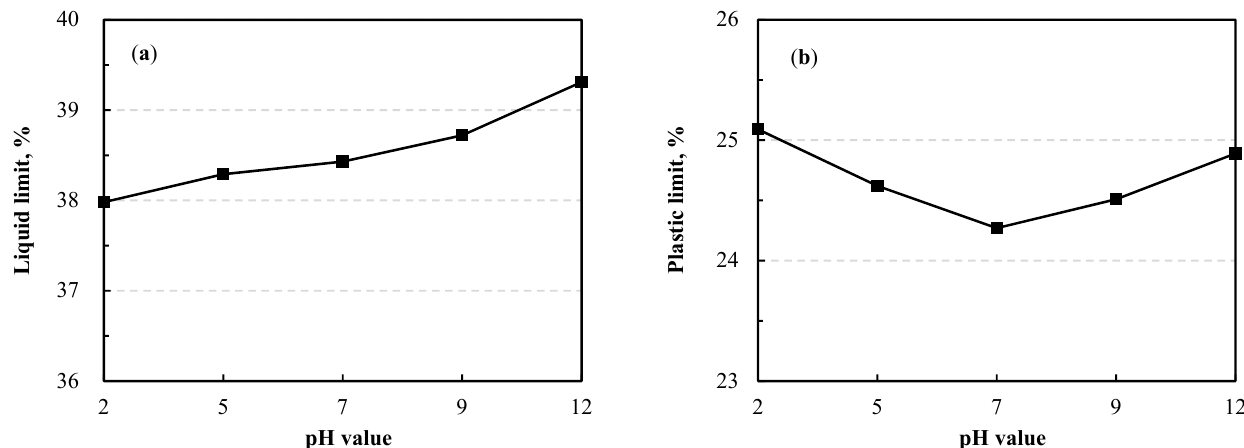
Figure 5. ( a ) Liquid limit; ( b ) plastic limit of the acid- and alkali-contaminated soils.